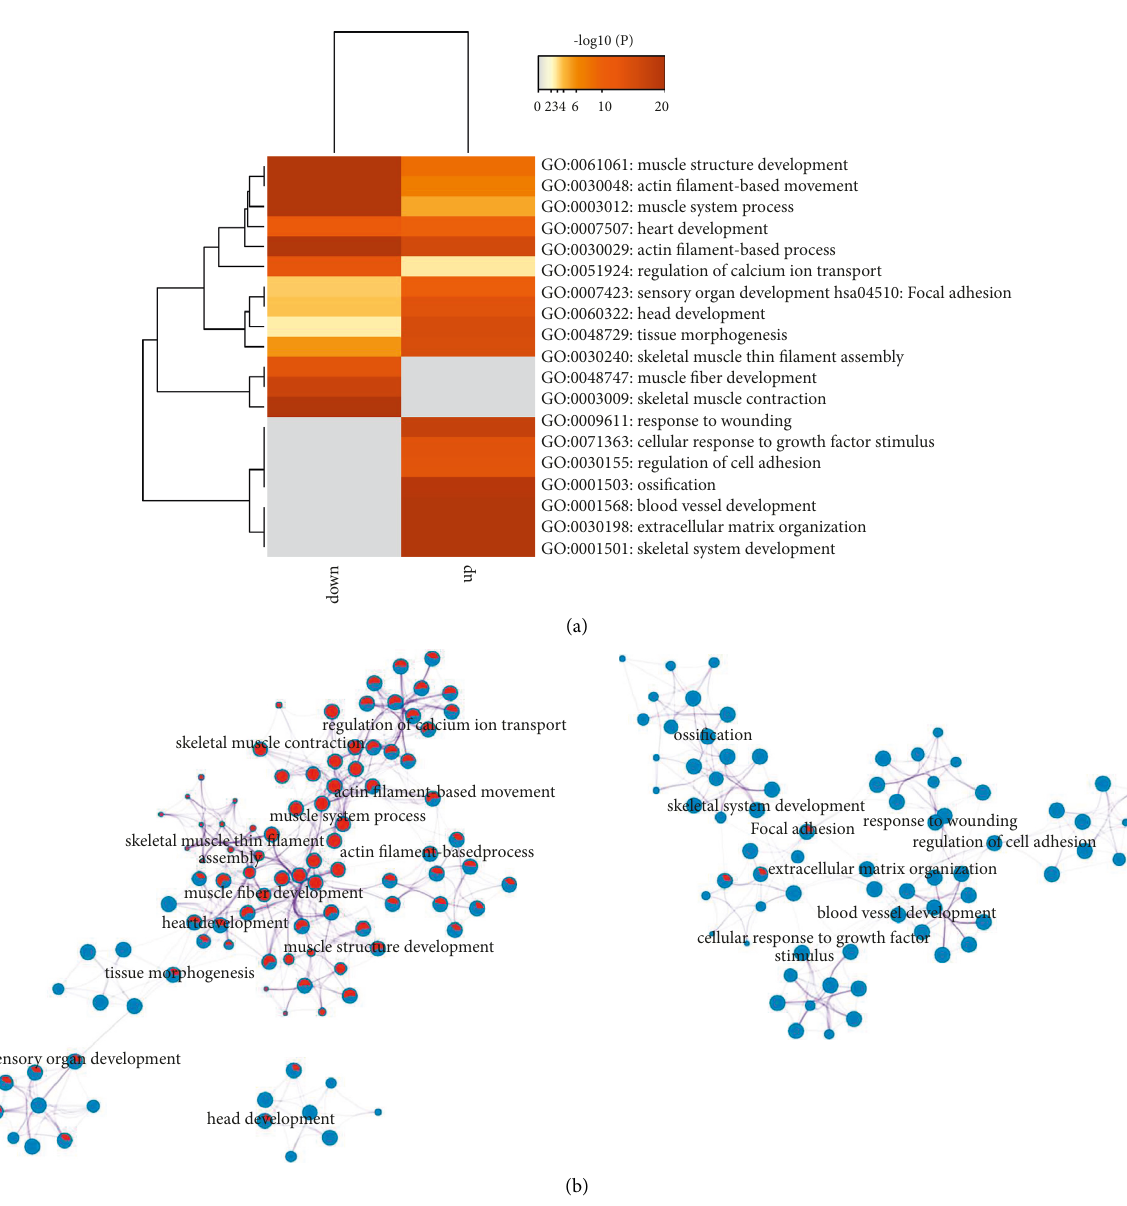
Figure 3: GO BP and KEGG pathways of upregulated and downregulated mRNAs. (a) Bar graph of the top 20 clusters. (b) The relationships among the enriched clusters from the KEGG analysis were visualized using